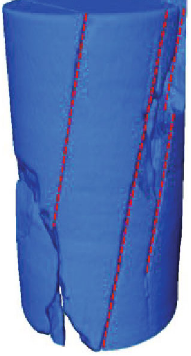
Figure 4: Failure modes of selected samples after uniaxial compression: (a) A-1; (b) A-2; (c) A-3; (d) B-1; (e) B-2; (f) B-3; (g) C-1; (h) C-2; (i) C-3. The dotted line represents the approximate position of the main fracture surface of